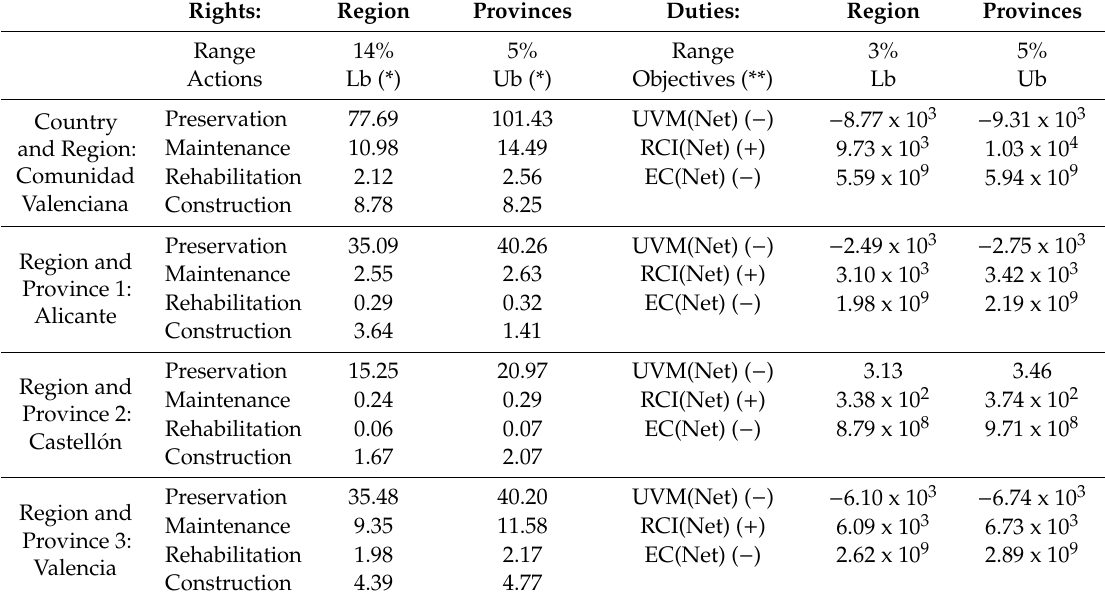
Table 4. Guidelines for decentralization alternative 66 for the issuing of relational contracts between central government and the region of Comunidad Valenciana, and between this region and its